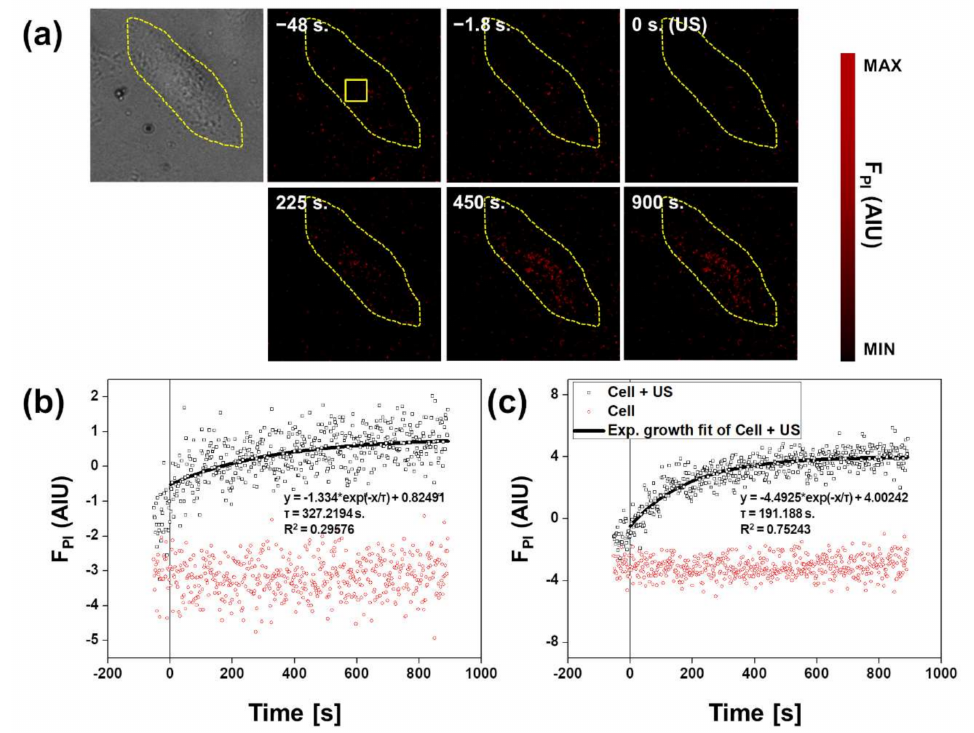
Figure 4. ( a ) Time-varying fluorescence images of intracellular PI in a cervical cancer cell with an ultrasound-microbubble cavitation. Background fluorescence signals were corrected. An inlet yellow box indicates a region of interest to determine intracellular PI fluorescence of the cervical cancer cell with the ultrasound-microbubble cavitation. ( b , c ) Plots of quantitative intensities of fluorescence from intracellular PI in the cervical cancer cell with the ultrasound-microbubble cavitation and the cell without the cavitation. Figure 3b indicates the quantitative intensities of intracellular PI for the entire region of cells, and Figure 3c means the intracellular PI intensities for a region of interest, which is represented as a yellow box, of the neighboring region in contact with the